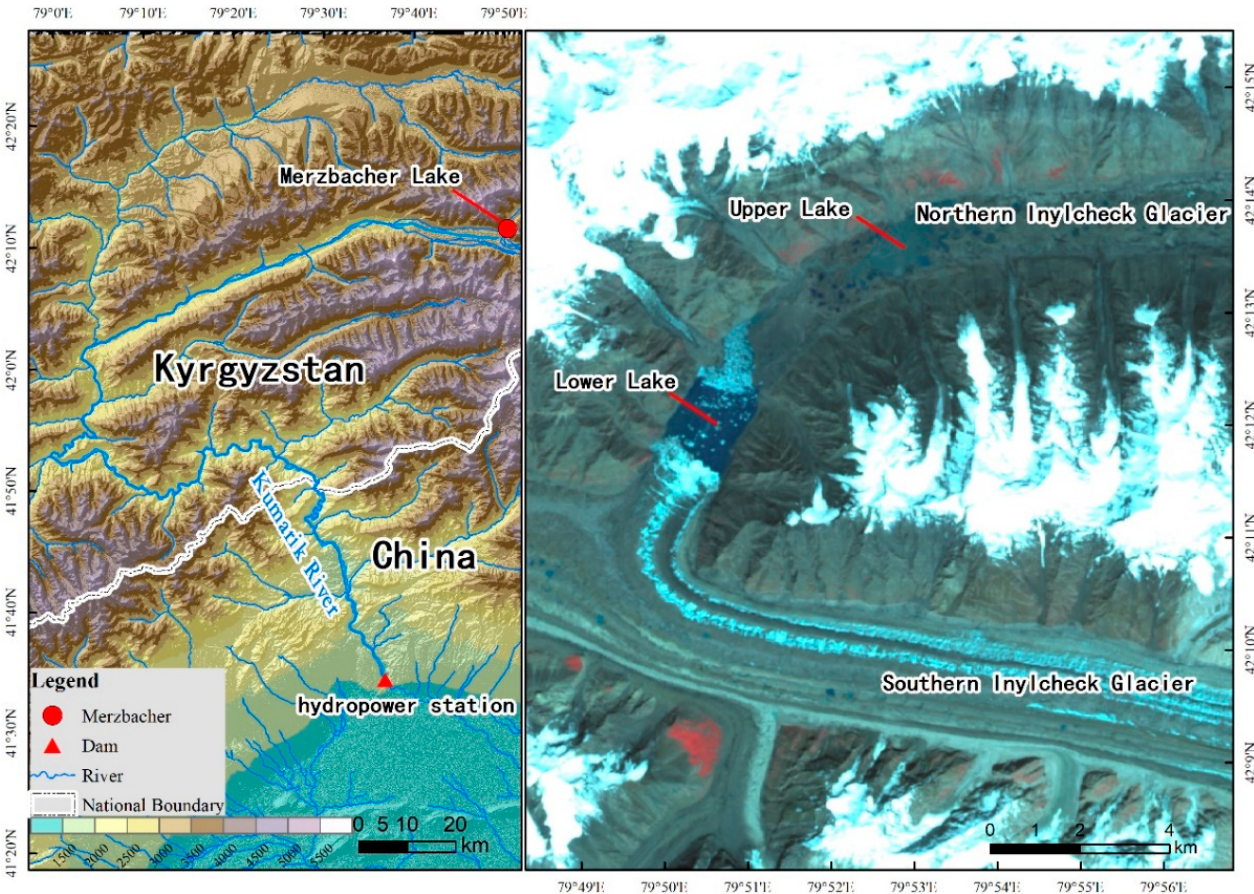
Figure 1. The location of lake Merzbacher.